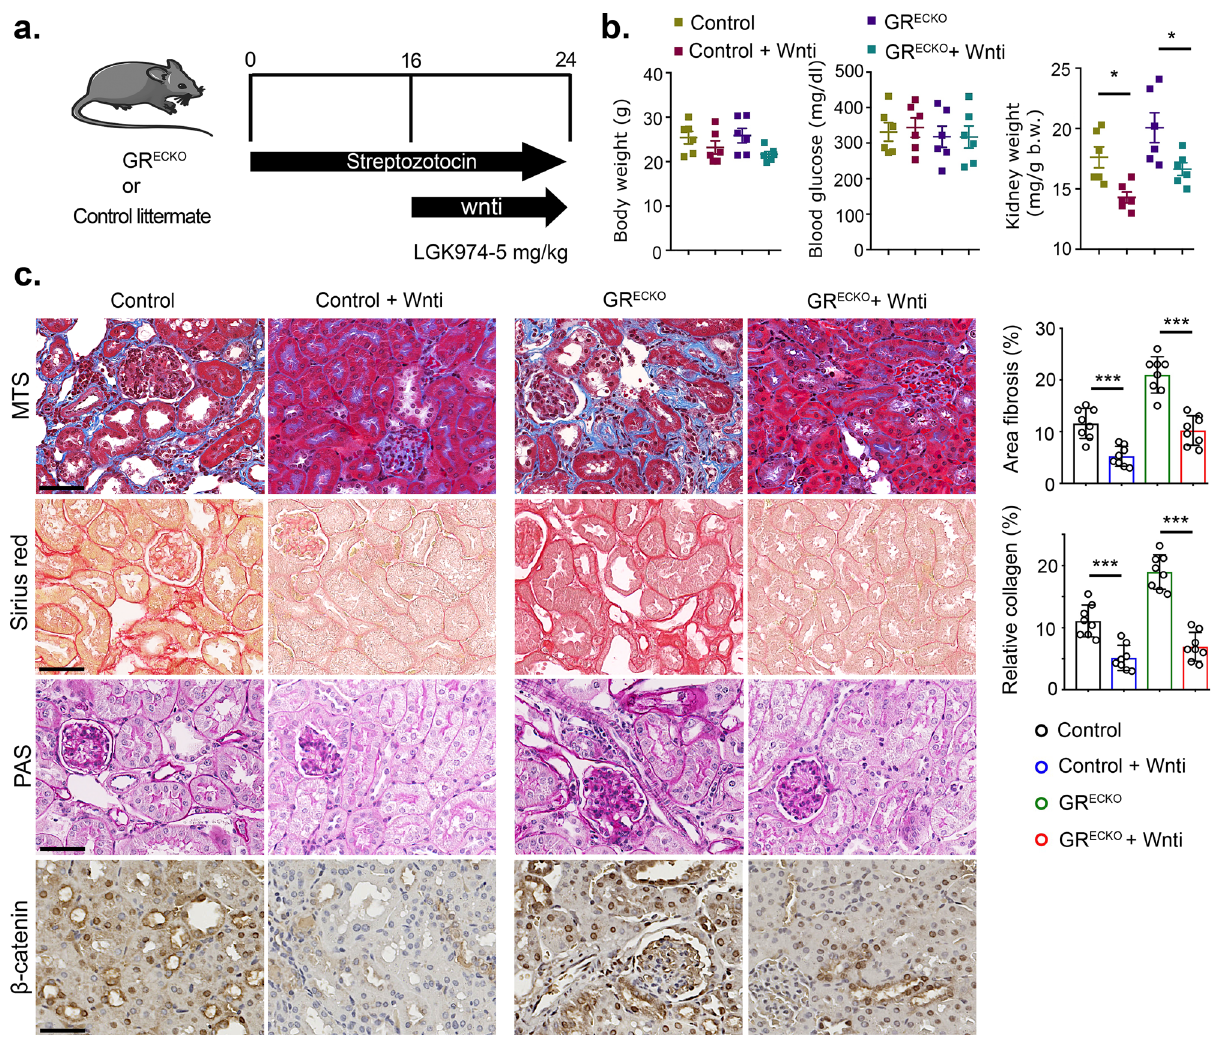
Fig. 5 Wnt inhibitor partially abrogates renal fi brosis in diabetic GR ECKO and DKO mice. a Schematic diagram showing the treatment protocol of Wnt inhibition in diabetic control and GR ECKO mice. b Physiological parameters including body weight, blood glucose, and kidney weight/body weight were analyzed. N = 6 biologically independent mice/group combined from two experiments. c Masson trichrome, Sirius red, and PAS staining as well as immunohistochemical analysis of β -catenin levels in the kidneys of wnti-treated diabetic control and GR ECKO mice. Representative images are shown; original magni fi cation ×300. Relative area of fi brosis (%) and relative collagen deposition (%) were measured using the ImageJ program. N = 8 biologically independent mice/group combined from three experiments were analyzed. Scale bar 50 μ m. Data are mean ± SEM. For all panels, one-way ANOVA with Tukey post-test was used for the analysis of statistical signi fi cance. Signi fi cance * p < 0.05, ** p < 0.01, *** p < 0.001. Source data are provided as source data fi le. Components of this fi gure were created using Servier Medical Art templates, which are licensed under a Creative Commons Attribution 3.0 Unported License;